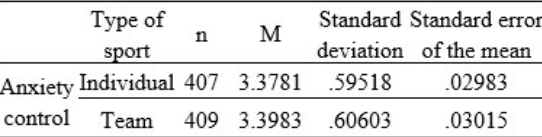
Table 4. Control of anxiety in relation